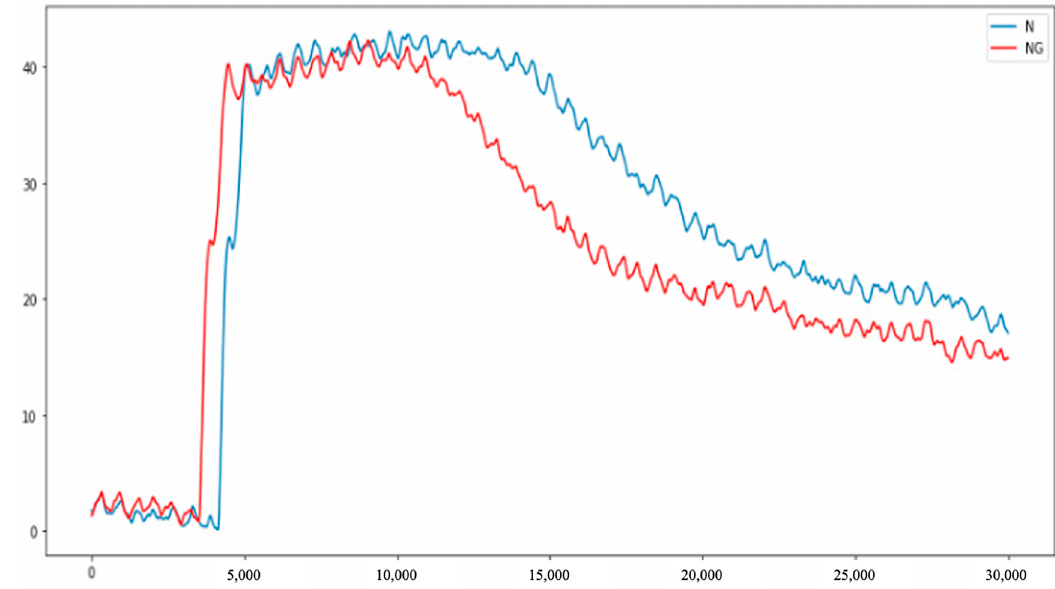
Figure 16. Pressure curve difference between non-defective and defective.